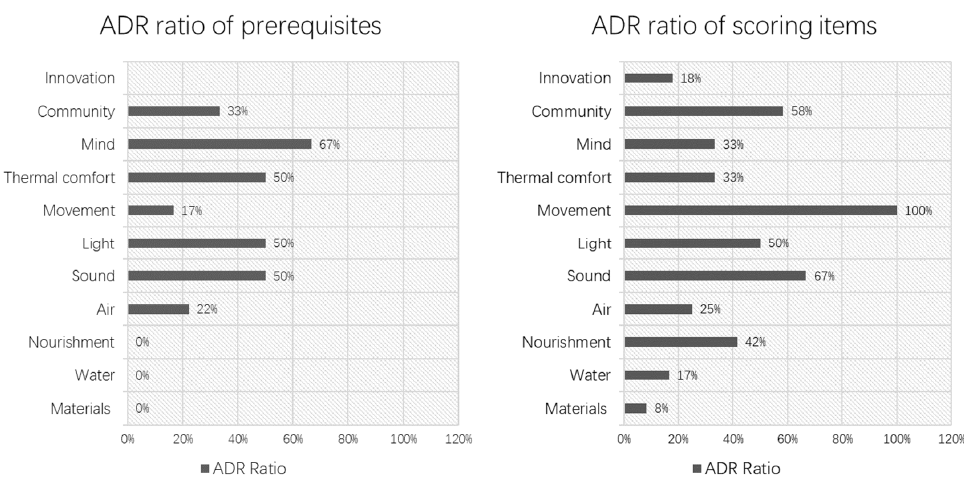
Figure A4. Breakdown of the number of prerequisites, the point of scoring items, and ADR ratios in diverse categories of WELL. (Source: by the author).